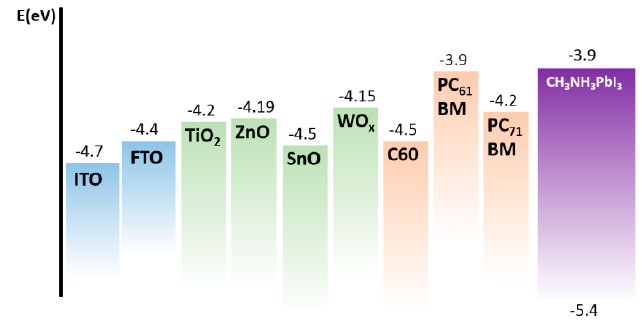
Figure 2. Summary of energy level of electron transport layer (ETL) materials and perovskite.